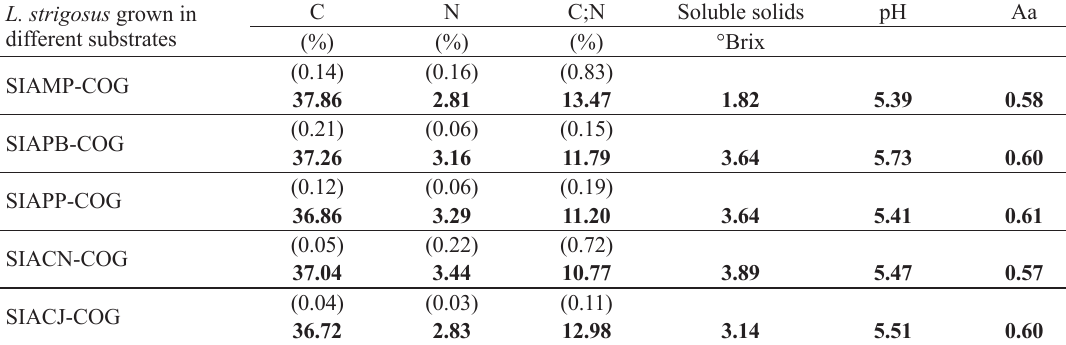
Results of physical and chemical (soluble solids, pH, Aa), carbon (C), nitrogen (N) and C:N ratio analyses of Lentinus strigosus mushroom grown in different